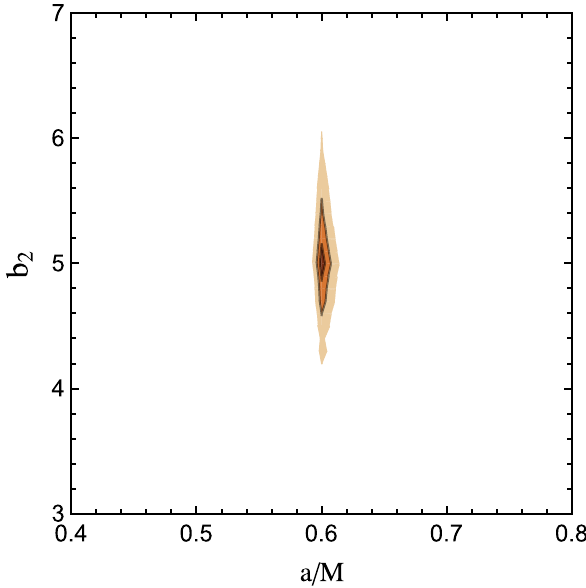
Fig. 4 Contour level from analysis of the 2D transfer function with GB BH as reference BH. Contour level is for parameters b 2 = 5, all other b i s are equal to 1. The reference model is a GB BH with a (cid:6) ∗ = 0 . 6 and i (cid:6) = 55 ◦ . See the text for more details